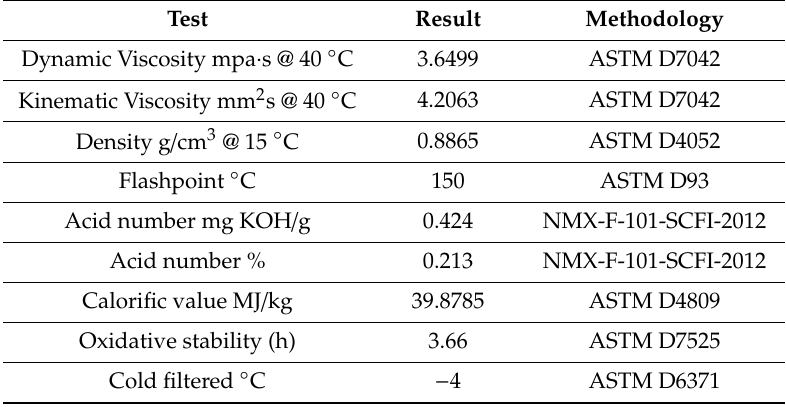
Table 6. Characteristics of